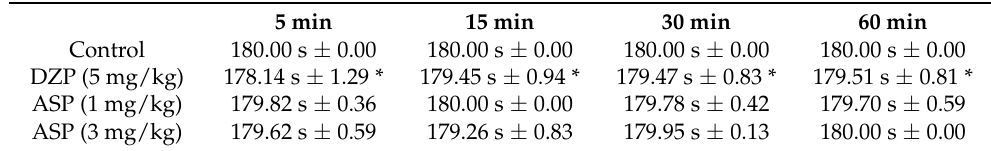
Table 1. Effects of Aspidocarpine on Swiss mice ( Mus musculus ) in the rotarod test.